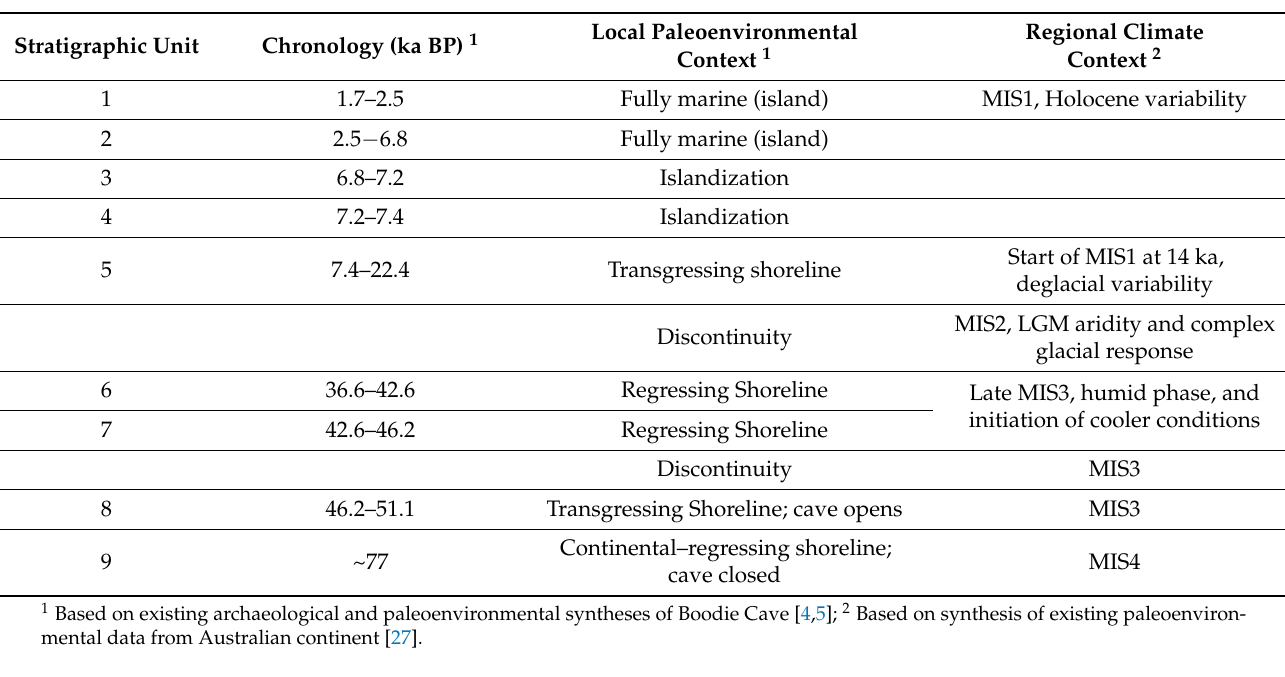
Table 2. Stratigraphic unit and corresponding chronological and paleoenvironmental context.